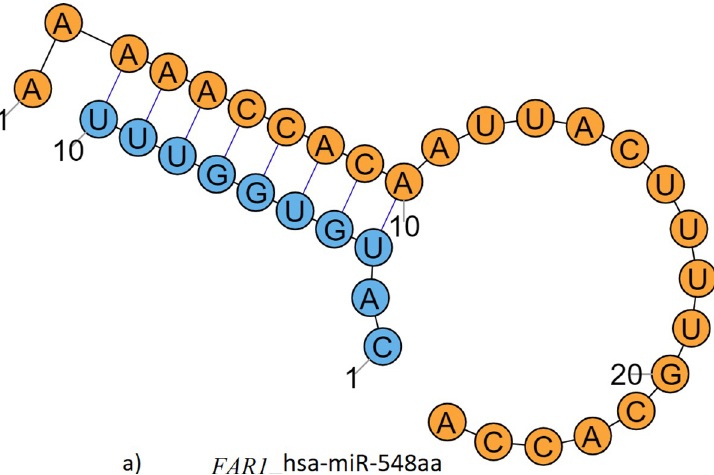
Fig 4. Schematic of mRNA-miRNA seed region hydrogen bond interactions in FGF12. (mRNA: Blue, miRNA: Scarlet).